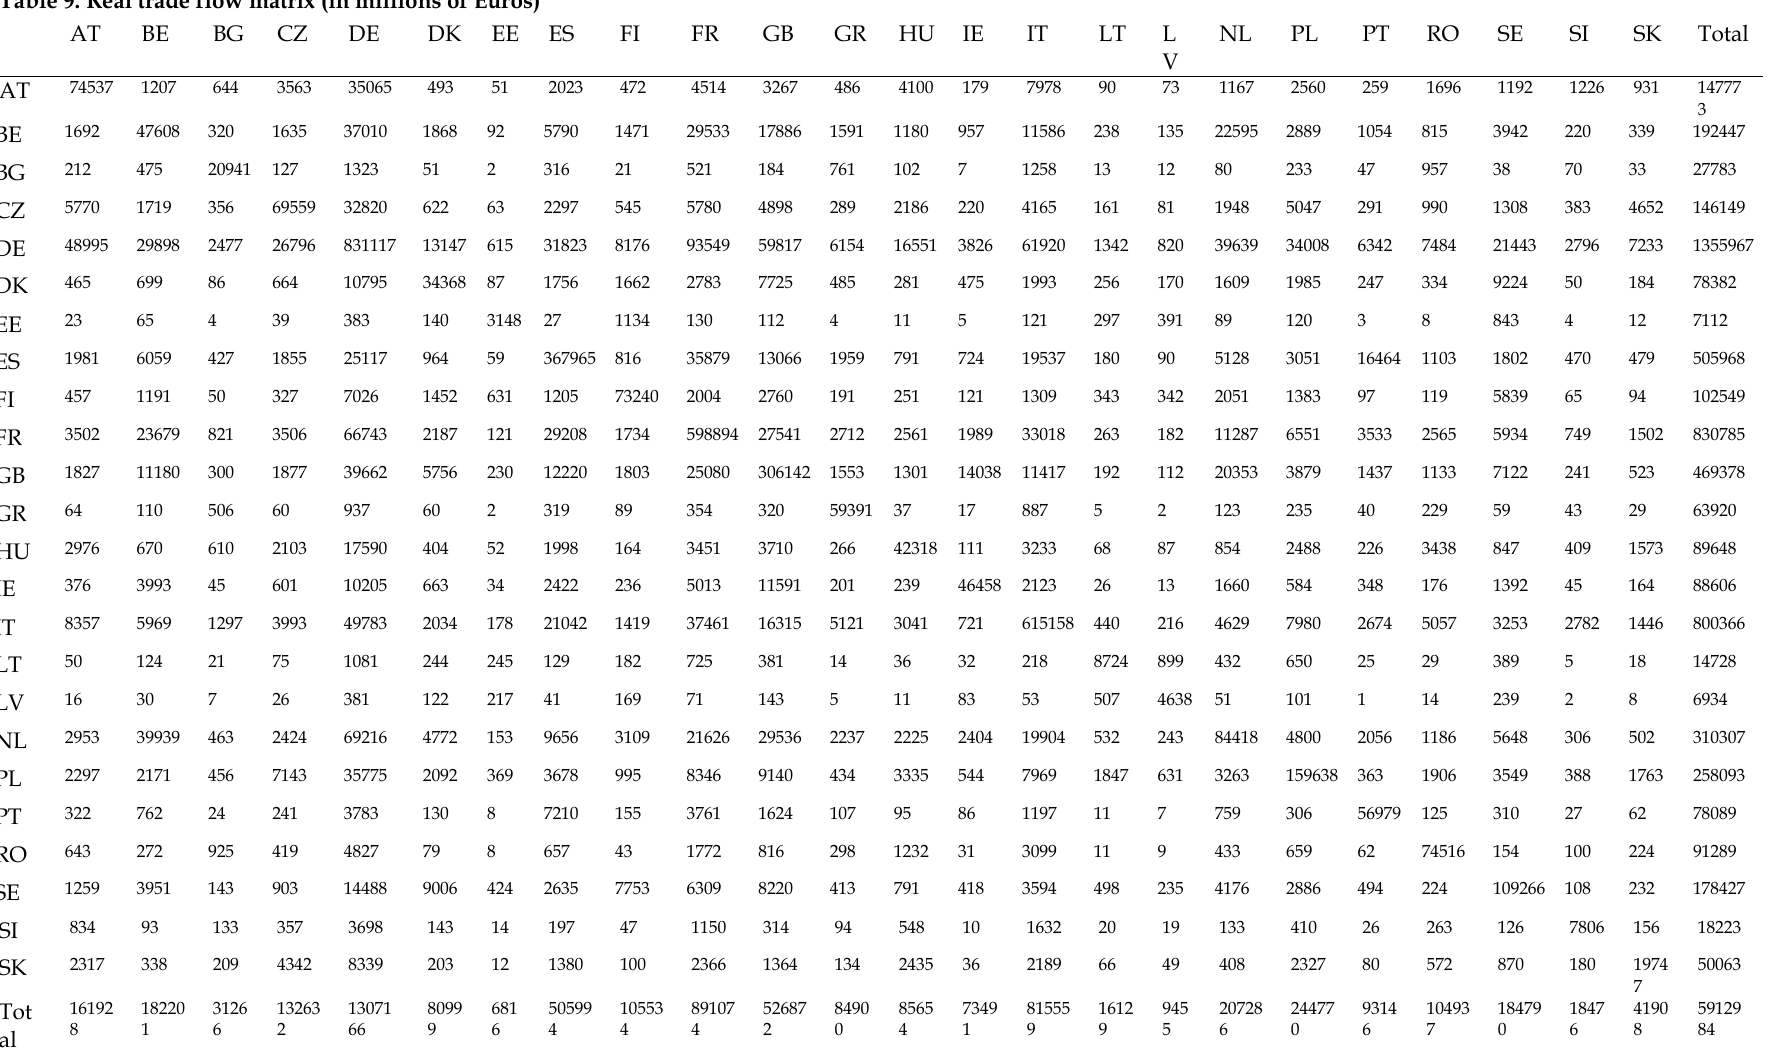
Table 9. Real trade flow matrix (in millions of Euros) AT BE